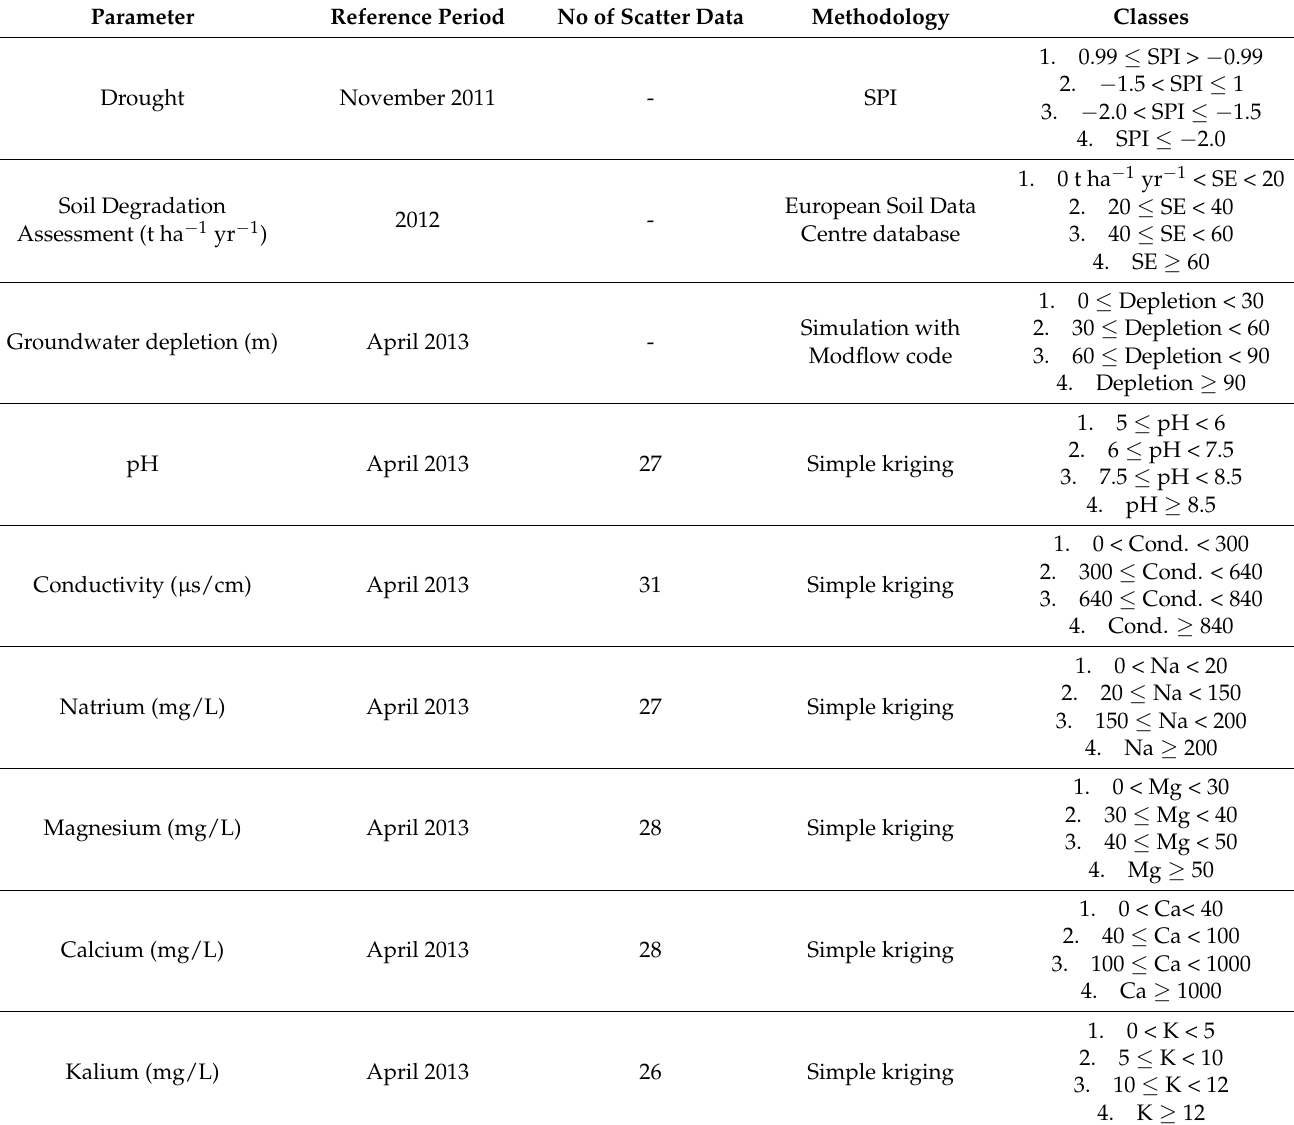
Table 4. Characteristics of parameters classes’ generation